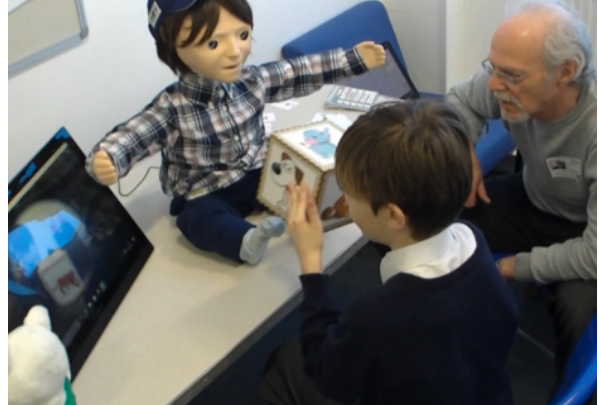
Figure 1: A child showing Kaspar an animal picture on the cube face. Each face shows a different animal so the child has to understand that what he sees is different from what Kaspar sees when the robot looks at the